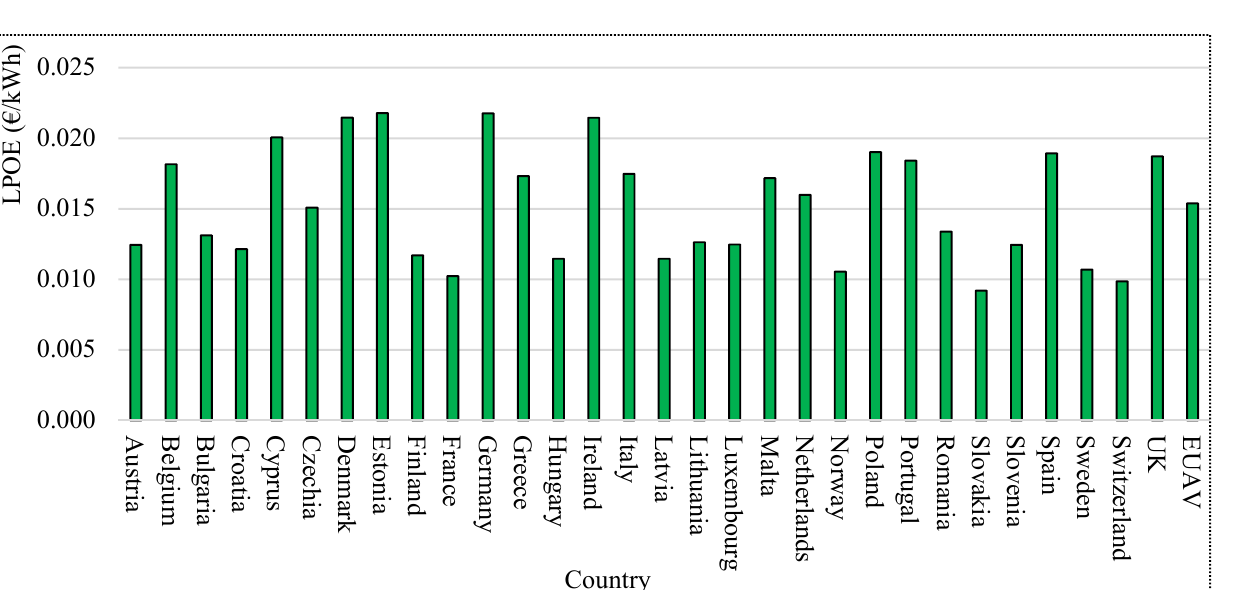
Figure 7. BIPV net present value of environmental benefits. 5. Performance of Non-Optimal Solutions Some studies from the literature claim a low performance or low efficiency of BIPV systems [36,37]. The lifetime of inverters is also controversial. Although new models in the market offer a warranted lifetime of 15 years, there are still many models in the market with a warranted lifetime of only ten years. Therefore, this section has investigated a scenario for a BIPV system with an efficiency of 10%, a lifetime of 25 years and an inverter replacement requirement for every ten years. The result is depicted in Figure 8, where it can be seen that the non-optimal performance of the BIPV system can significantly change the LCOE analysis and increase it meaningfully. In this case, the average LCOE of BIPV in Europe has been doubled (from 0.15 €/kWh to 0.3 €/kWh). This shows the importance of system design, system component selection and system implementation.